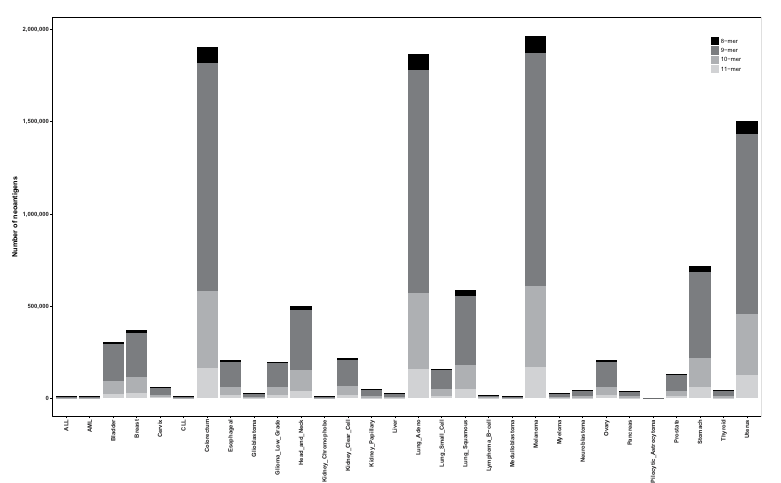
Figure 5. The distribution of neoepitopes across cancer types. Melanoma, colorectum cancer and lung adenocarcinoma have the largest numbers of neoepitopes, which correlates with the number of ASSs that occur in these cancers. Although the cancer variants originate due to different mutation mechanisms, depending on the type of cancer, the distributions of neoepitopes and peptide lengths were